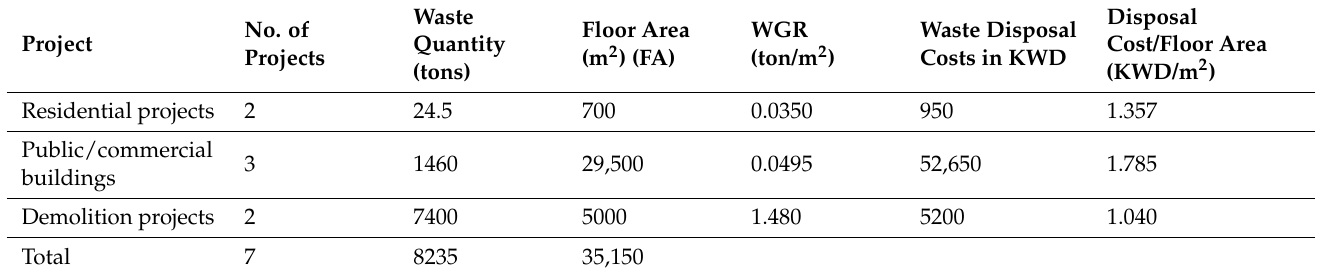
Table 2. Waste generation rates (excluding soil/earth) and disposal